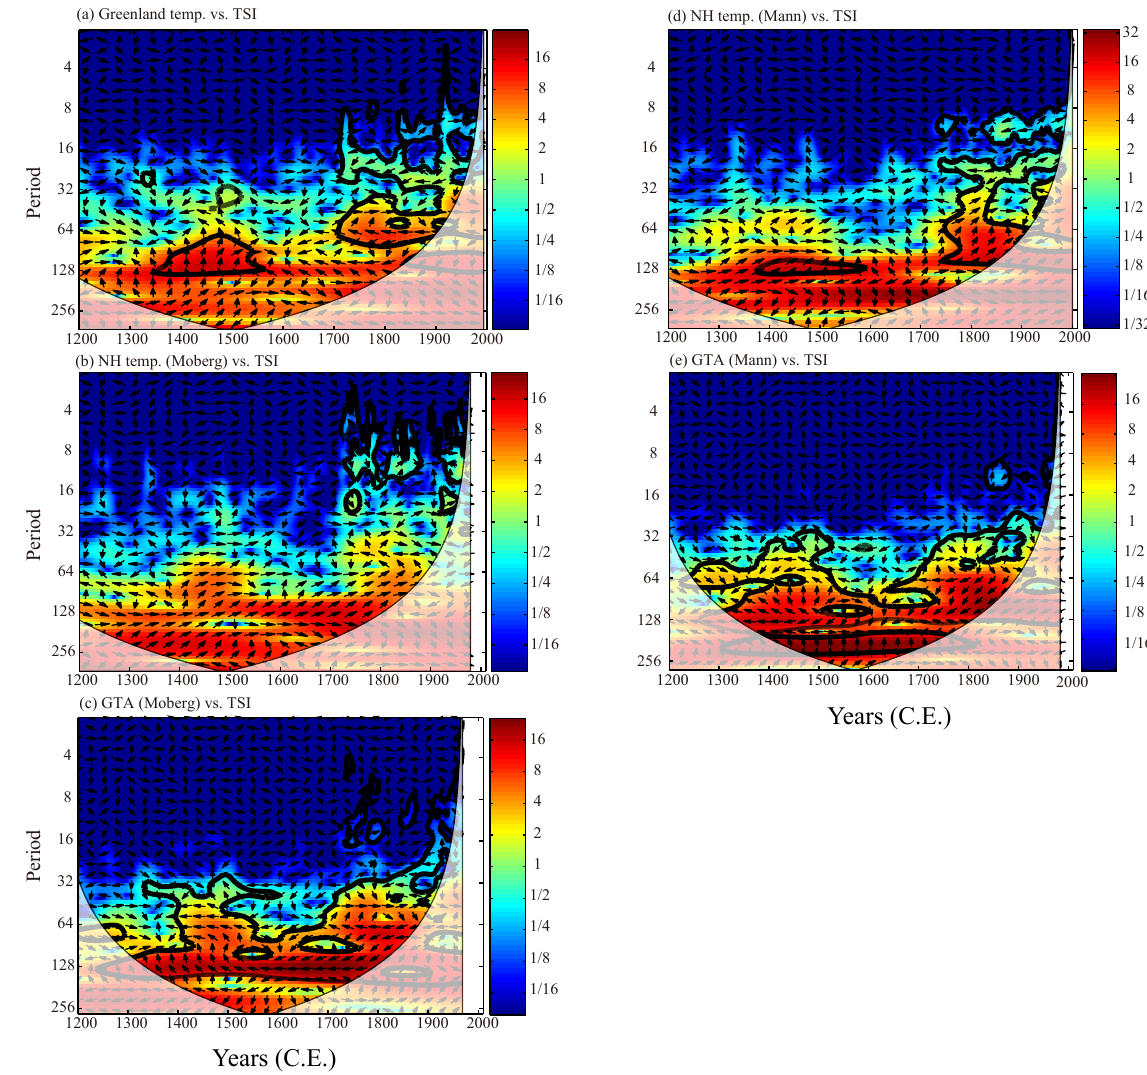
Fig. 4. Cross-wavelet transform (XWT) (Grinsted et al., 2004) of Greenland temperature, the NH temperature, the GTA [ G − NH ] , and the NAO, all vs. TSI, for 1200–2010. (a) Greenland temperature (Kobashi et al., 2010) vs. TSI (Lean et al., 1995; Bard et al., 2000; Crowley, 2000) for 1200–2010; (b) the NH temperature (Moberg et al., 2005) vs. TSI (Lean et al., 1995; Bard et al., 2000; Crowley, 2000) for 1200– 2010; and (c) the GTA [ G − NH ] with the NH temperature from Moberg et al. (2005) vs. TSI (Lean et al., 1995; Bard et al., 2000; Crowley, 2000) for 1200–2010; (d) the NH temperature (Mann et al., 2009) vs. TSI (Lean et al., 1995; Bard et al., 2000; Crowley, 2000); (e) the GTA [ G − NH ] (Moberg et al., 2005) vs. TSI (Lean et al., 1995; Bard et al., 2000; Crowley, 2000). Annual resolution data are used for the analyses except the GTAs [ G-NH ] . The area between the grey lines represents the 95% confidence level relative to the noise (red). Arrows indicate relative phase relationships, with in-phase relationships denoted by right-facing arrows; arrows pointing straight down indicate that the phase of the TSI leads that of Greenland temperature, the NH temperature, or the GTA [ G − NH ] by 90 ◦ . Shaded areas represent the cone of influence where edge effects may distort the